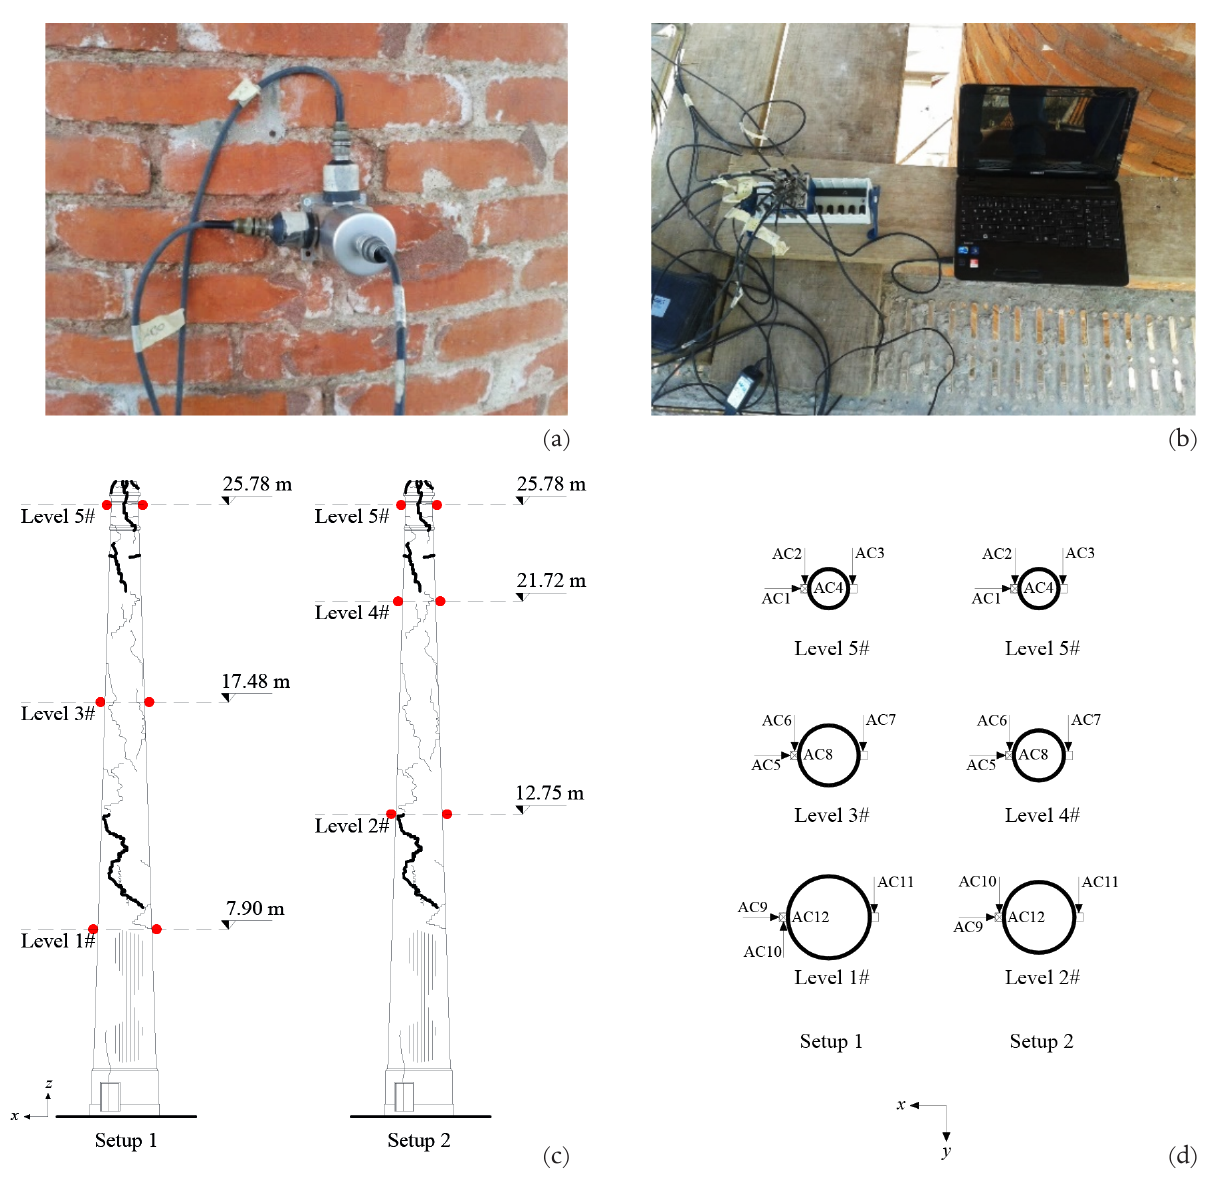
Figure 4. Operational modal analysis: (a) deployment of piezoelectric accelerometers; (b) data acquisition system; (c) test setups - the measuring points are marked in red; and (d) monitored